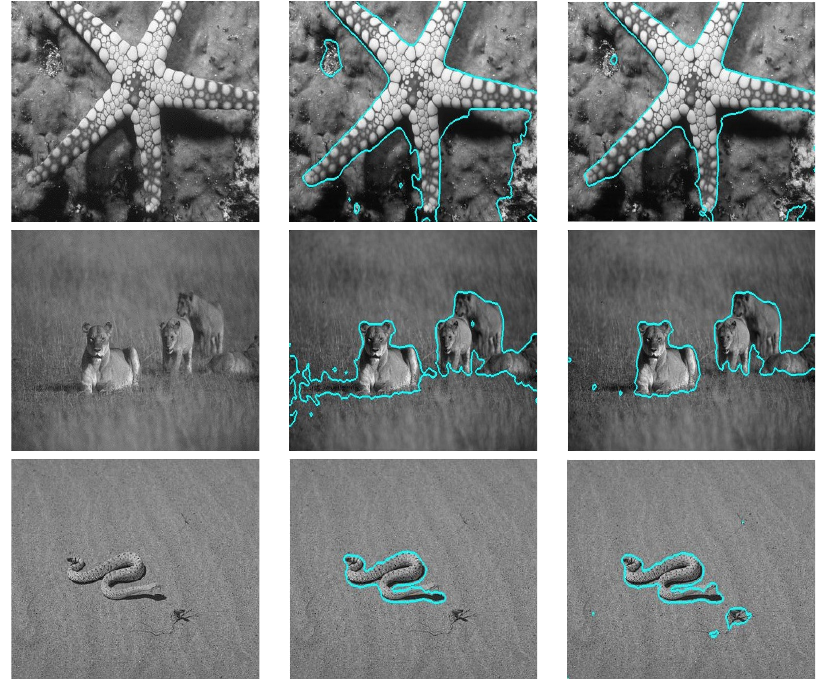
Figure 5. Left column: Original images coming from the Berkeley database which presents textured features. Central column: segmentation results based on the [13]. Right column: our segmentation